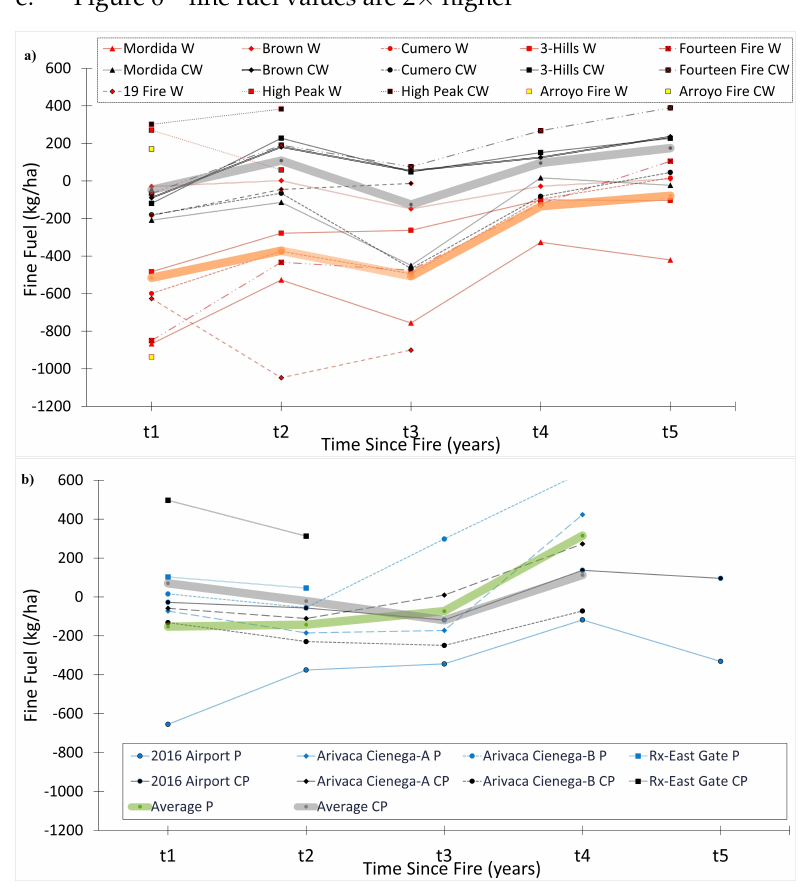
Figure 6. Changes in post-fire fine-fuel (kg/ha) for ( a ) naturally occurring wildfires (W; red) and ( b ) prescribed (P) fires (blue), with comparable unburned control areas (C; black), surrounding burn perimeters, in relation to time since fire (t1 = 1 year post fire) at BANWR. Average post-wildfire (orange), average post-prescribed fire (green), average control of wildfire (CW; gray), and average control of prescribed fire (CP; gray) fine-fuel. Note : t0 (not shown) = year of fire. f. Tables A1–A3—mean of fine fuels are 2 × higher Table A1. The yearly estimated mean ( µ ) of fine-fuels (kg/ha) within burn perimeters for wildfire (W) and prescribed (P) fires at BANWR, with parenthesized boldface values indicating pre-burn estimates prior to ignition (some ignition dates do not align with calendar date but rather to pre- or post-imagery dates) against 1-km buffered control (C) areas around fire perimeters (parenthesized italicized values reference ignition time period for unburned control